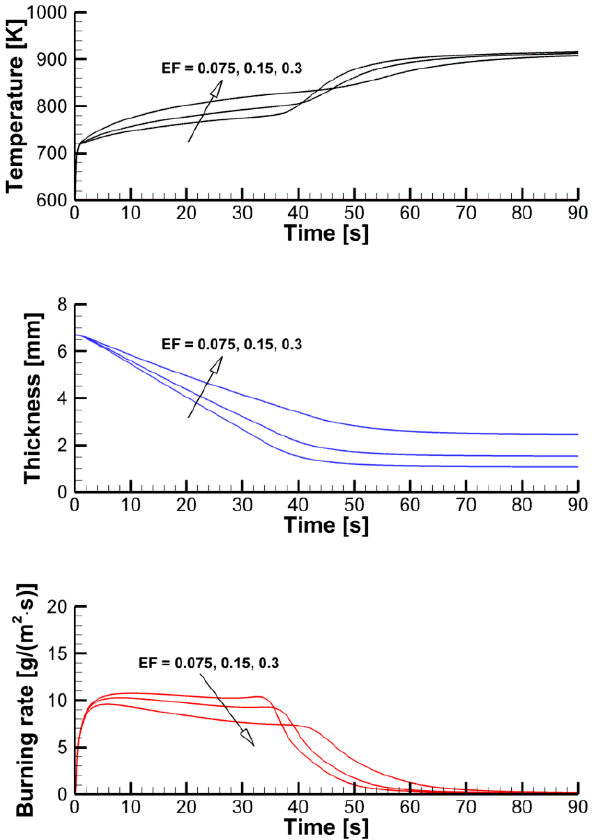
Figure 16. Transient variation of the temperature of the exposed surface, sample thickness, and mass loss rate predicted in simulations of sample heating and decomposition with prescribed surface incident heat fluxes and three values of the expansion factor.